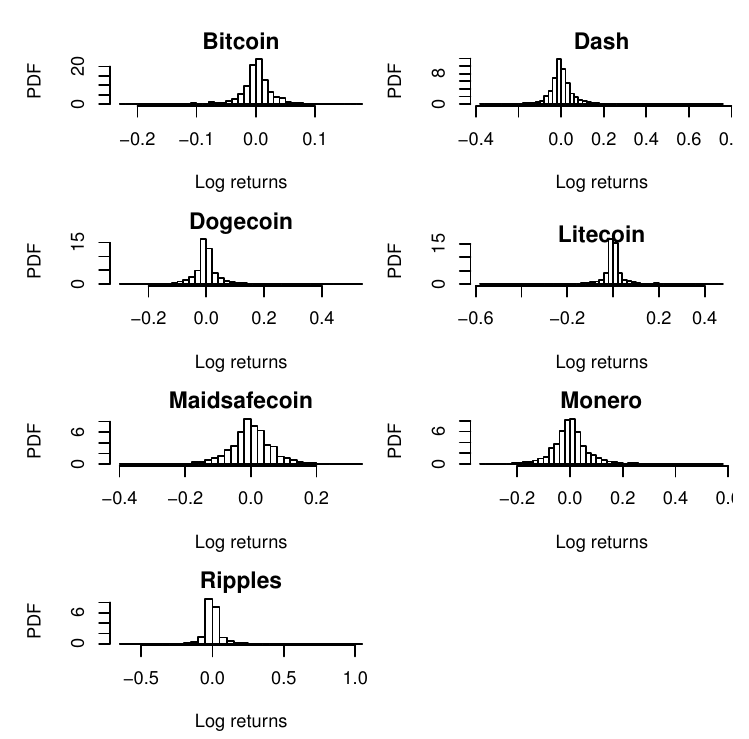
Figure 1. The histogram of the log returns of the exchange rates of Bitcoin, Dash, Dogecoin, Litecoin, Maidsafecoin, Monero and Ripple from 22 June 2014–17 May